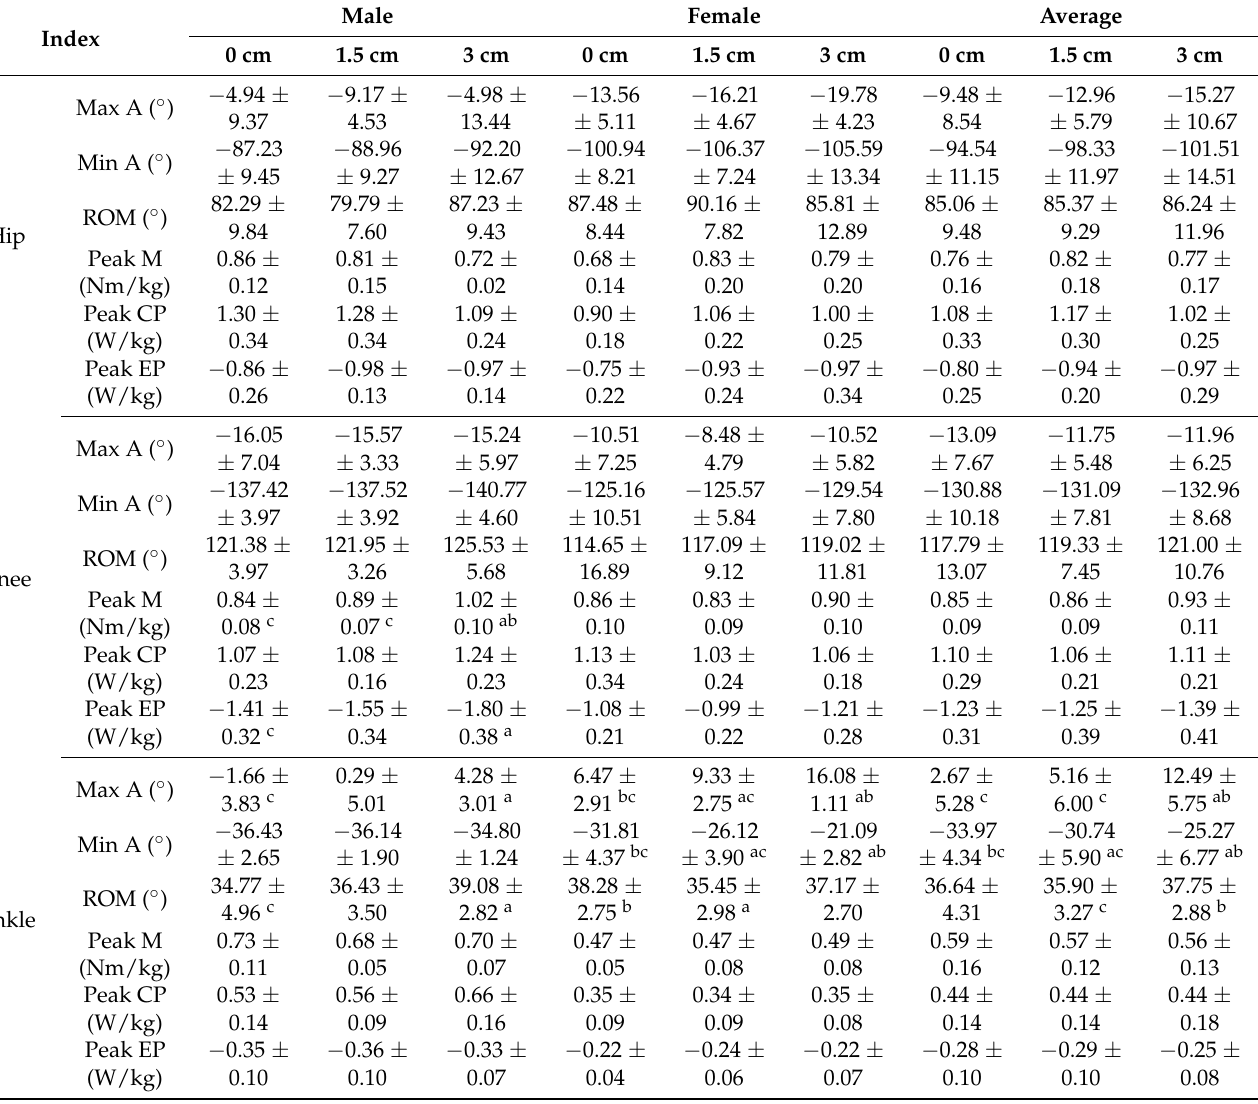
Table 2. Joint angle, joint moment, and joint